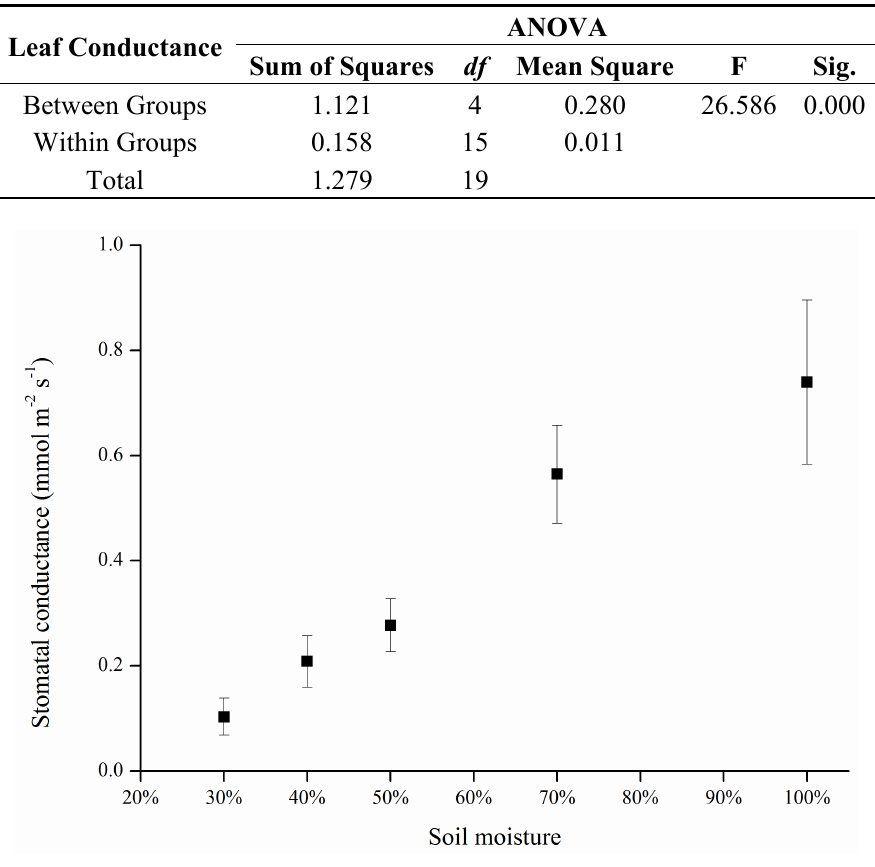
Figure 3. Leaf stomatal conductance under different water stress conditions showing gradient